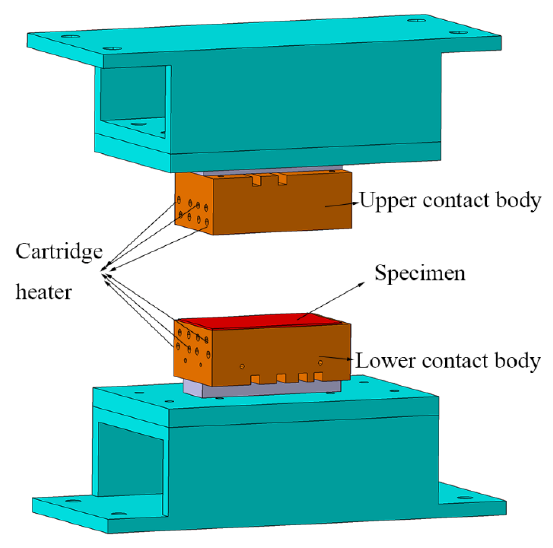
Figure 1. Experimental device.